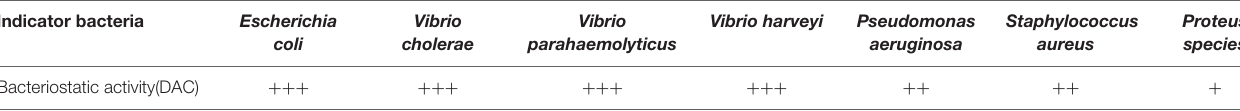
TABLE 3 | The bacteriostatic activity of MB01 on indicator bacteria. Indicator